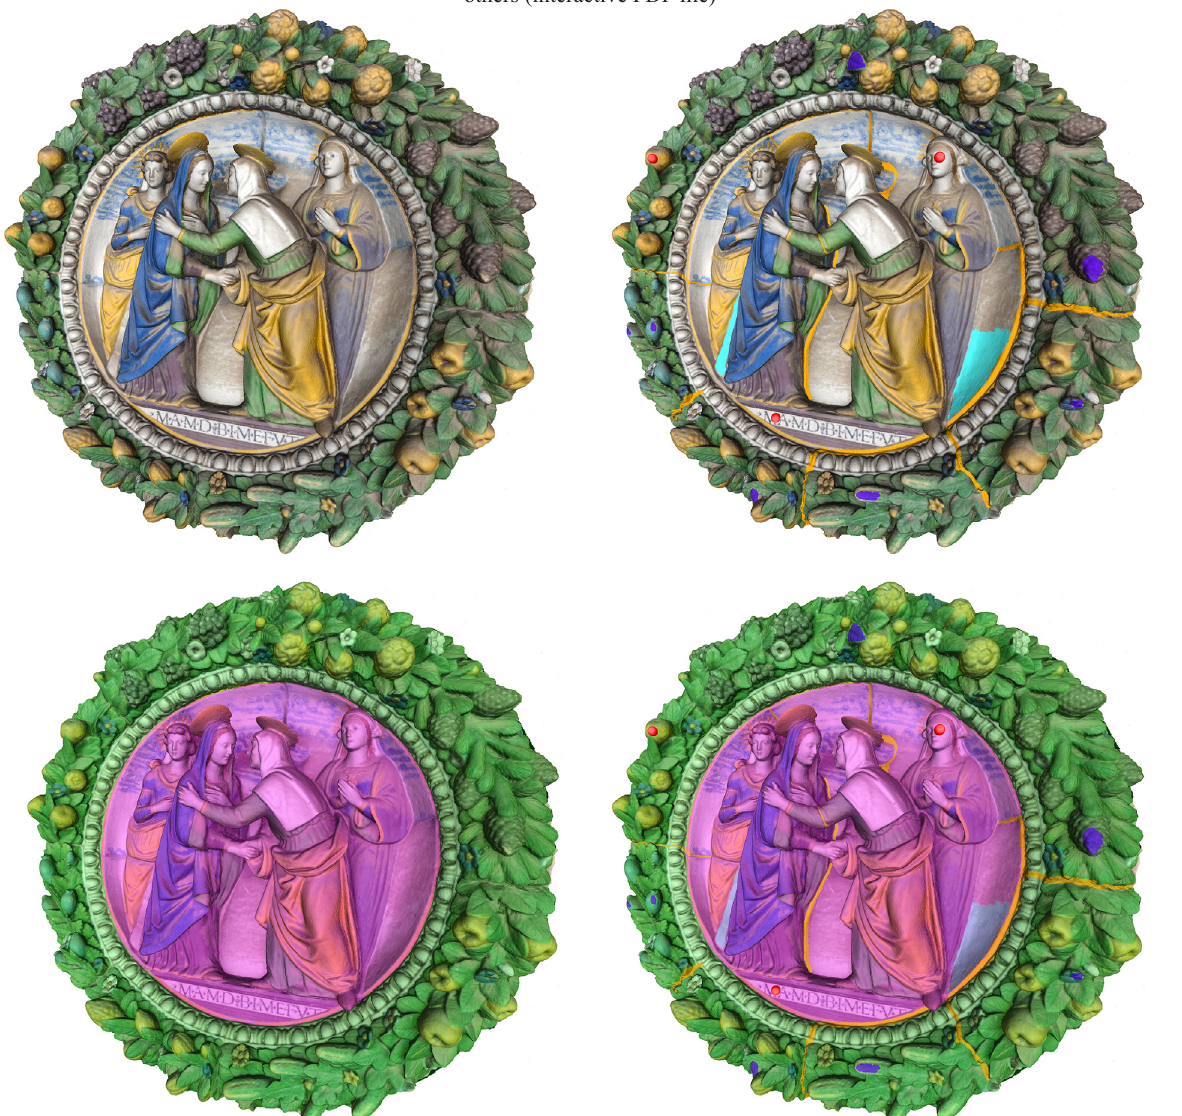
Figure 5. 3D interactive PDF with thematic maps related to investigation and conservation